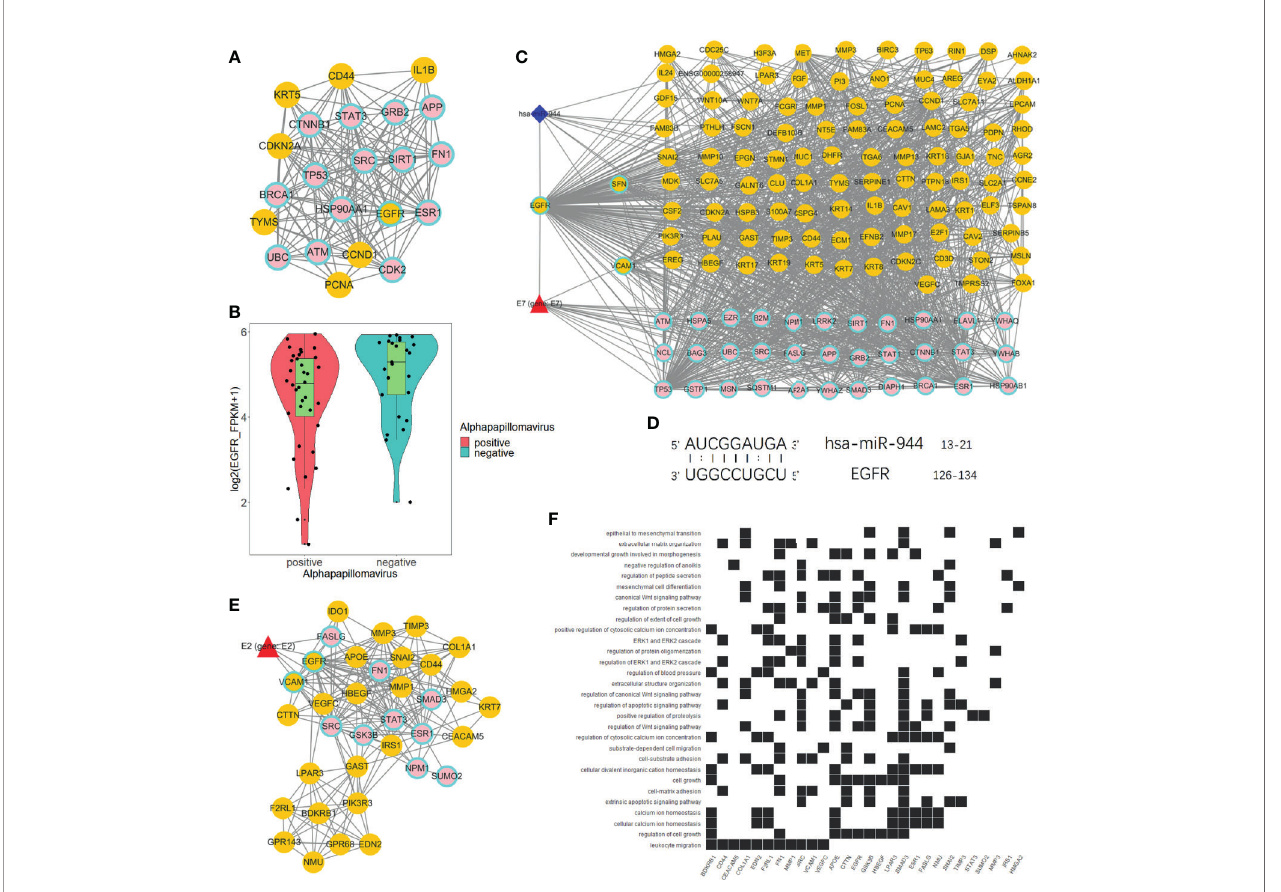
FIGURE 4 | Analysis of EGFR-related network. (A) Hub genes of global network, including 15 HPV manipulated genes; seven DEGs are not regulated by HPV and one HPV regulated DEG. (B) EGFR express status in HPV+ and HPV − samples respectively according to RNA-Seq FPKM from ICGC PCAWG project CESC and HNSC data. (C) Subnetwork of EGFR fi rst neighbors. (D) EGFR RNA binding prediction site with hsa-miR-944 using RIsearch2 software. (E) MCODE-calculated EGFR containing network cluster. (F) EGFR containing cluster GO and KEGG enrichment